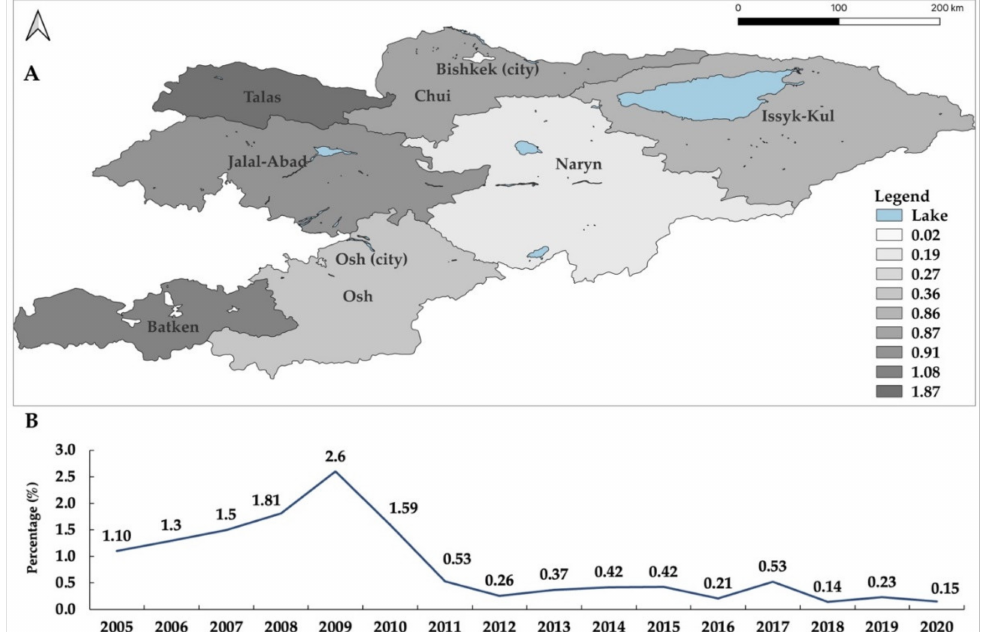
Figure 4. The seroprevalence of brucellosis in small ruminants by oblast in Kyrgyzstan from 2010 to 2020 ( A ). The seroprevalence of brucellosis in small ruminants 2005 to 2020 ( B ). Small ruminants were positive in two consecutive Rose–Bengal plate test and/or serum agglutination tests, based on reports of the SIVPS. The map was created using QGIS 3.22 Białowie˙za software which is available online [26].